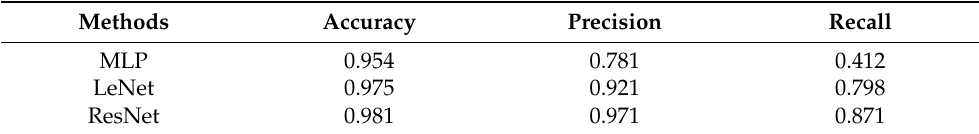
Table 2. Comparison of the results obtained by the three models for the Zhongma landslide. Methods